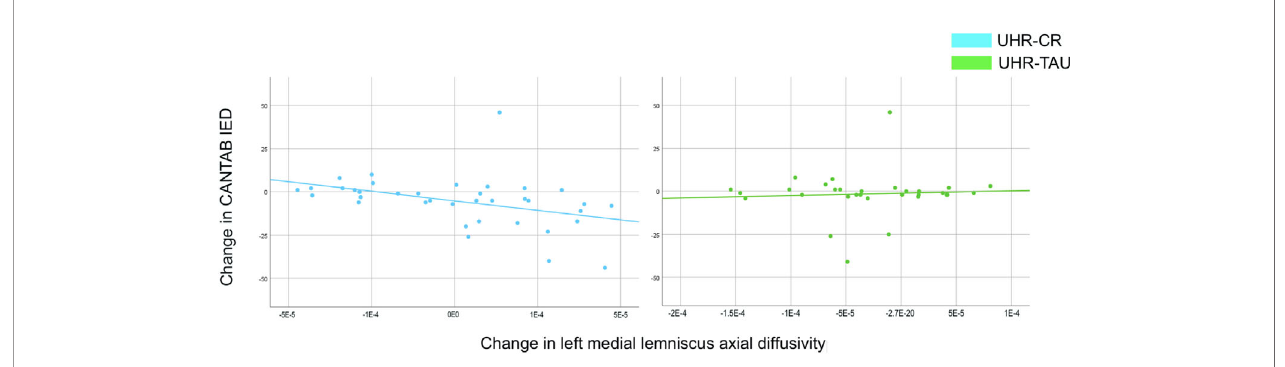
FIGURE 3 | The scatterplots illustrate the exploratory correlations between changes in left medial lemniscus axial diffusivity and changes in mental fl exibility (CANTAB IED total errors adjusted) in UHR individuals allocated to cognitive remediation versus treatment as usual are displayed. Error-bars indicate the 95% con fi dence intervals. Note that the y-axis has been altered to enhance visual display. The correlations have been tested with and without outliers, which were included due to no effect on the result. Numerical results are reported in detail in Supplementary Table S4 . CANTAB, Cambridge neuropsychological test automated battery; CR, cognitive remediation; IED, intra-extra dimensional set-shifting; TAU, treatment as usual; UHR, ultra-high